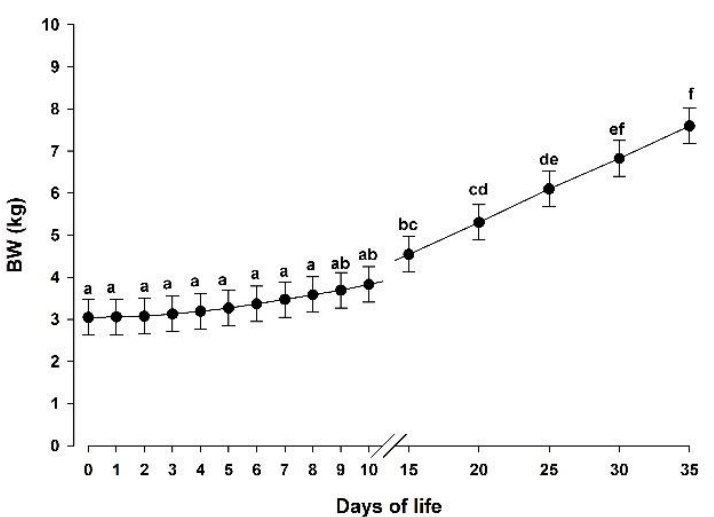
Figure 1. Body weight (BW) in the three groups together (MR-NS, MR-DHA-9 and MR-DHA-18; n = 30) from day 0 to day 35 of life. Different lowercase letters (a–f) indicate significant ( p < 0.05) differences between time points. Results are presented as least squares means ± standard error of the mean. p -values are shown in Table 3. MR-NS: milk replacer without supplementation of a microalgae- derived product rich in DHA; MR-DHA-9: milk replacer with supplementation of 9 g of a microalgae-